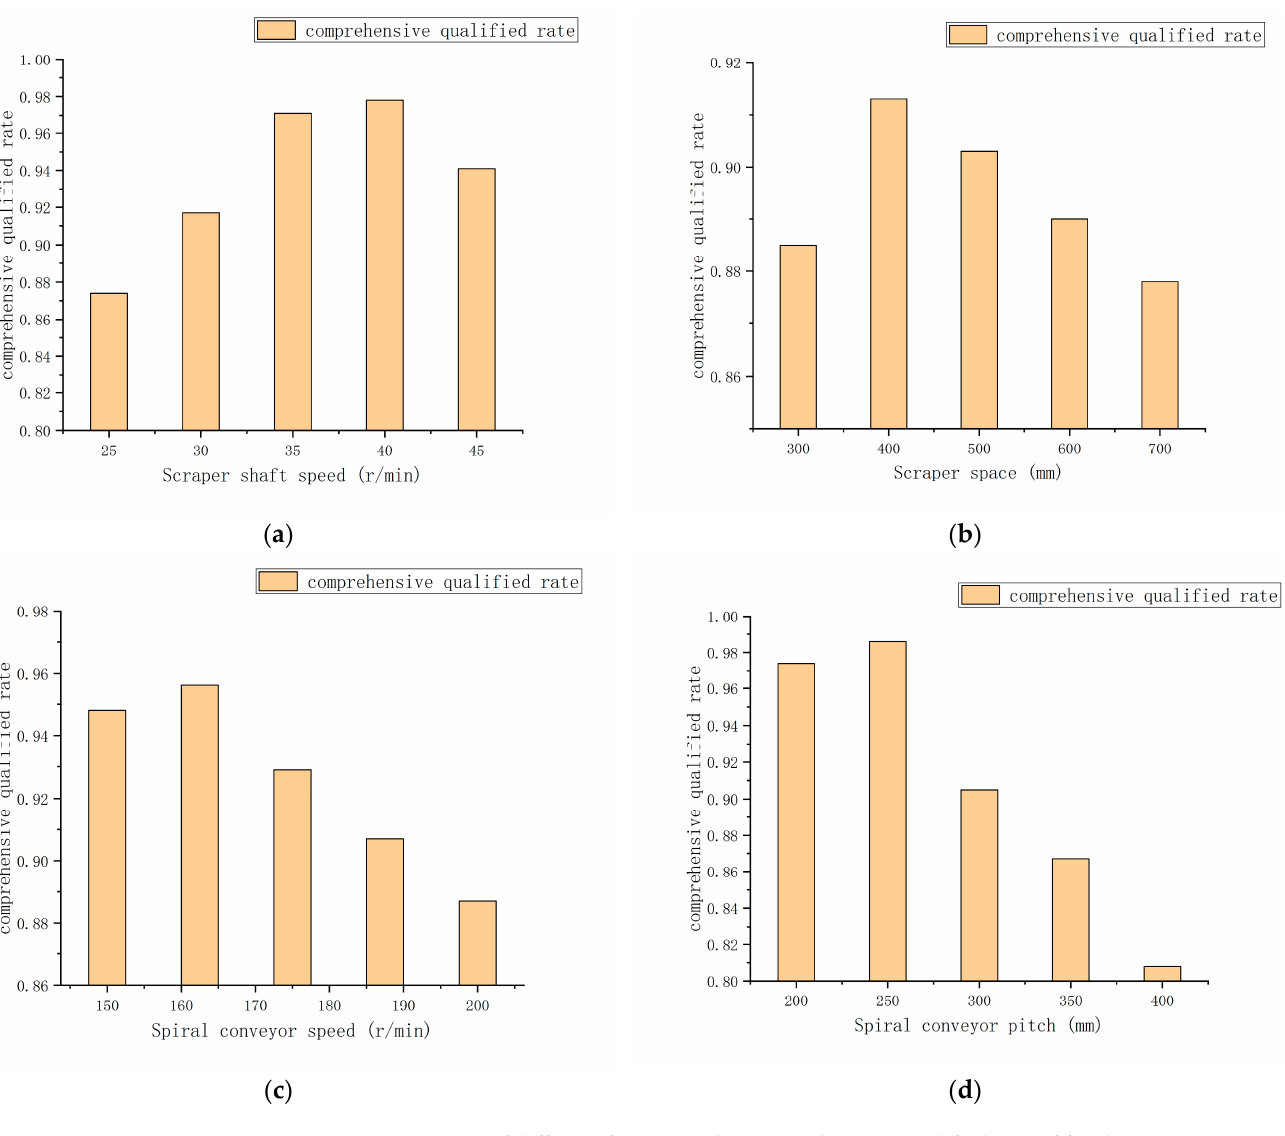
Figure 6. Impacts of different factors on the comprehensive qualified rate of fertilization. ( a ) Impact of scraper shaft speed on the comprehensive qualified rate of fertilization; ( b ) impact of scraper space on the comprehensive qualified rate of fertilization; ( c ) impact of spiral conveyor speed on the comprehensive qualified rate of fertilization; ( d ) impact of spiral conveyor pitch on the comprehensive qualified rate of fertilization.